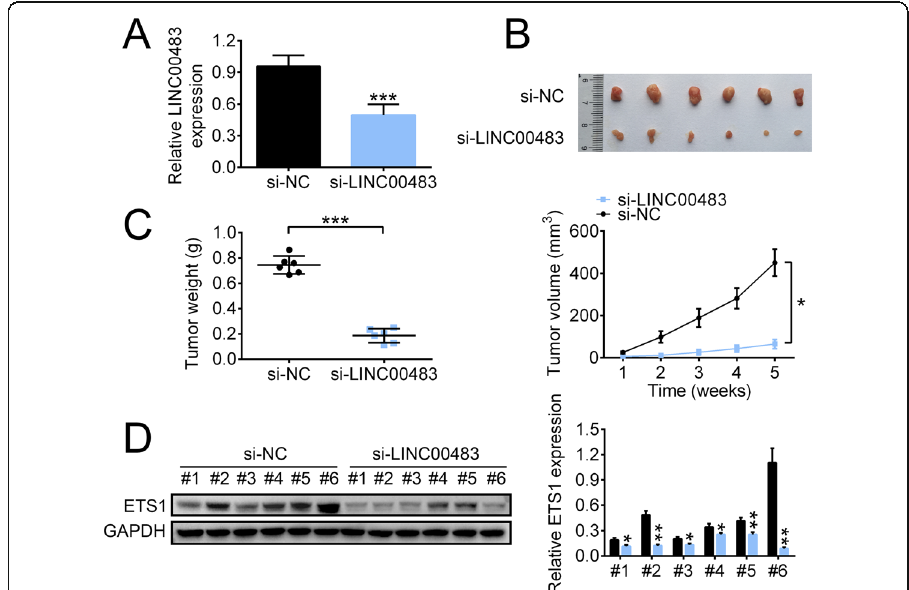
Fig. 6 LINC00483 silencing inhibited tumor growth and decreased ETS1 expression. a The RNA level of LINC00483 after LINC00483 silencing was measured using real-time PCR. b and c Tumor weight ( b ) and volume ( c ) were measured after LINC00483 silencing. d The protein level of ETS1 in tumors was determined using western blotting, * p < 0.05; *** p <